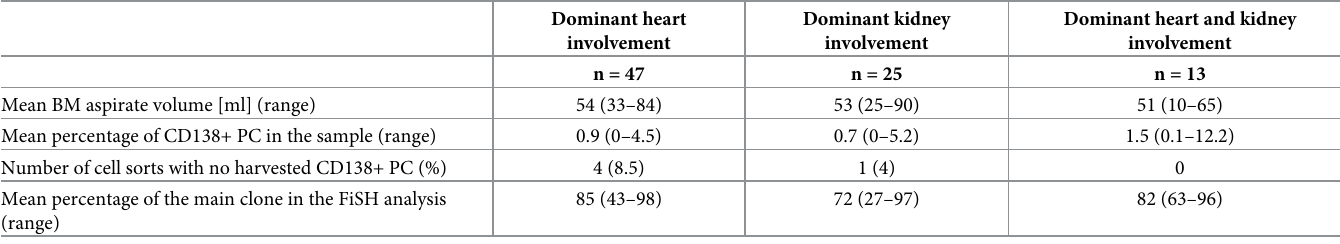
Table 1. Comparison of the CD138+ cell-sorting and of the main clone in the FISH-analysis.